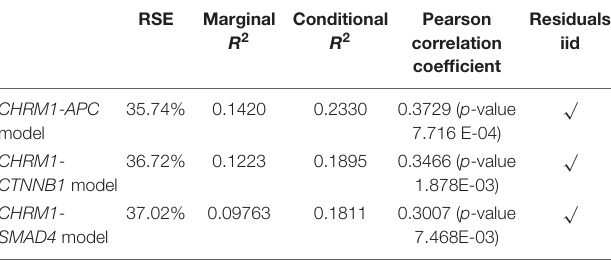
TABLE 1 | Model evaluation of equations described in Table 3 .